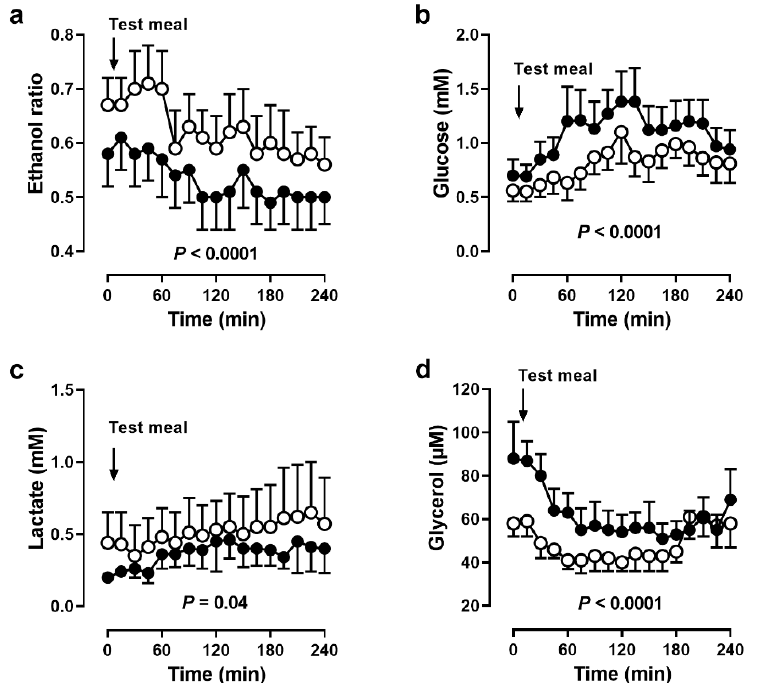
Figure 4. Adipose tissue microdialysis. ( a ) Ethanol ratio and dialysate concentrations of ( b ) glucose, ( c ) lactate and ( d ) glycerol in adipose tissue before and after a meal in 5 men before (open circles) and during (closed circles) Bah á ’ í fasting. Data are presented as means (SEM), p values by